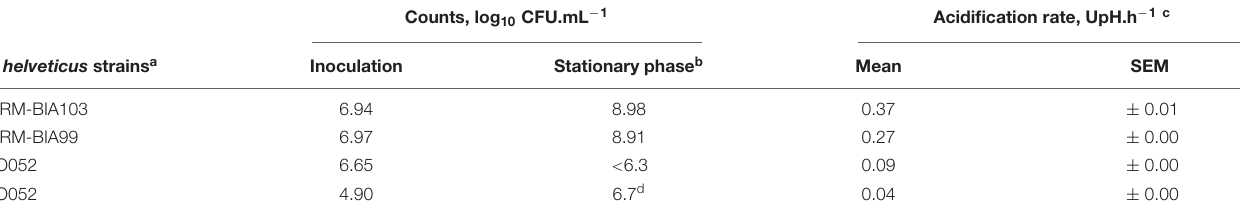
a See Table 1 . b Reached after approximately 12 h.